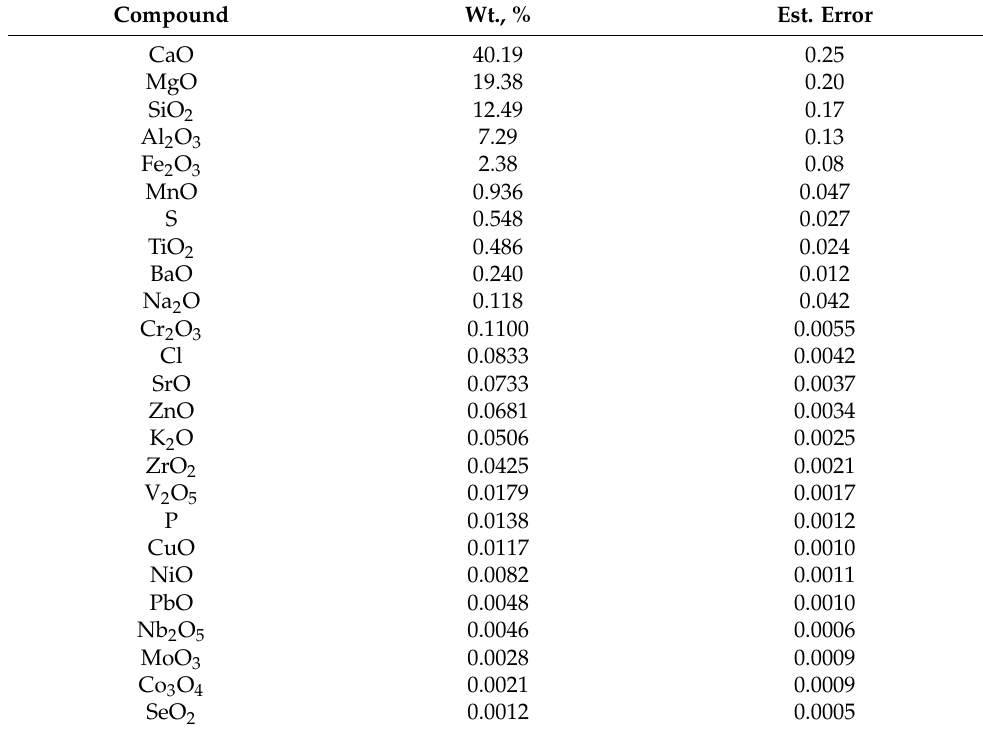
Table 4. Results of the X-ray fluorescence of ladle furnace slag.